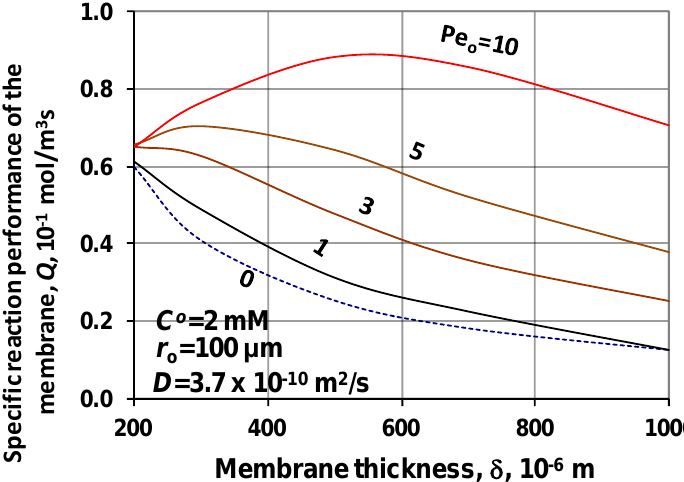
Figure 13. Specific reacted amount of substrate in the biocatalytic membrane layer as a function of the membrane reactor thickness, with parameter of the Pe o -number ( D = 3.7 × 10 − 10 m 2 / s; r o = 100 µ m; C O = 2 mM; N =